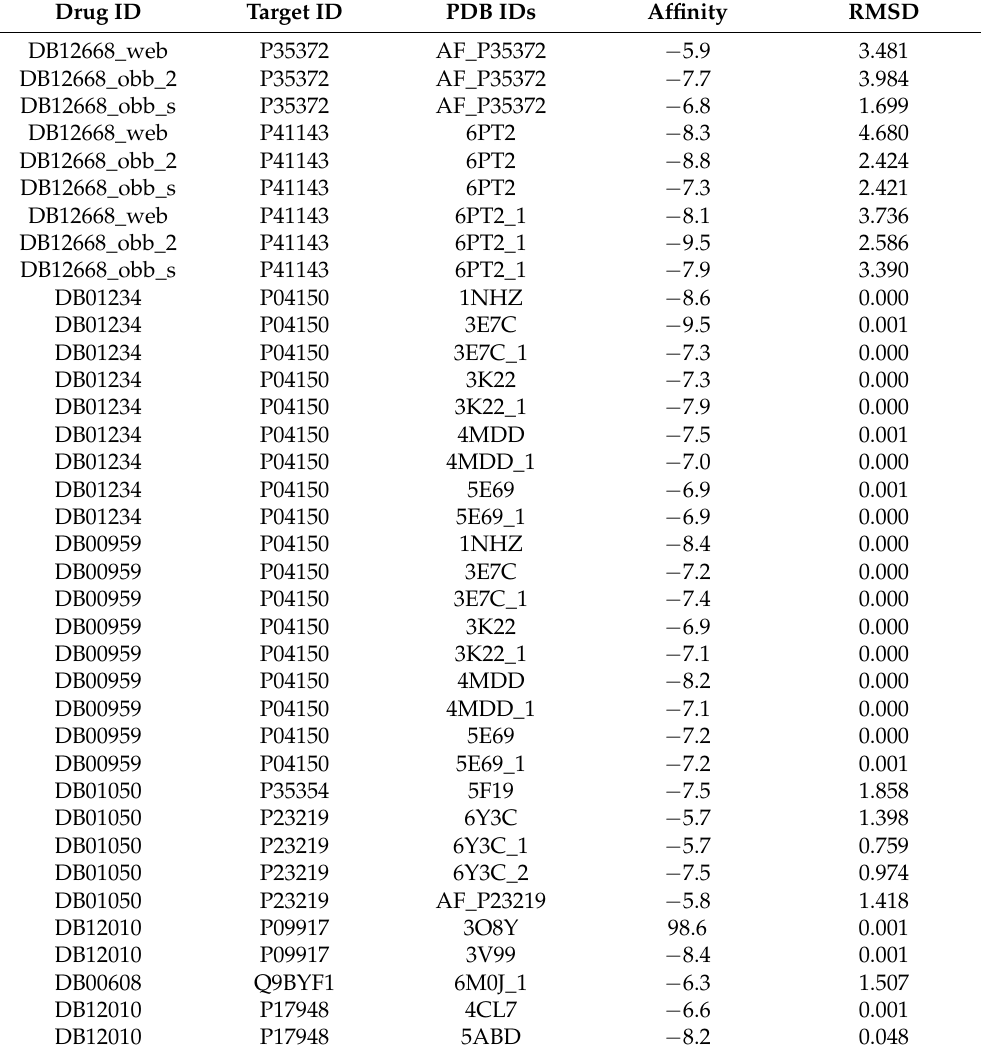
Table 3. Docking results for drug–target pairs with the top scores.